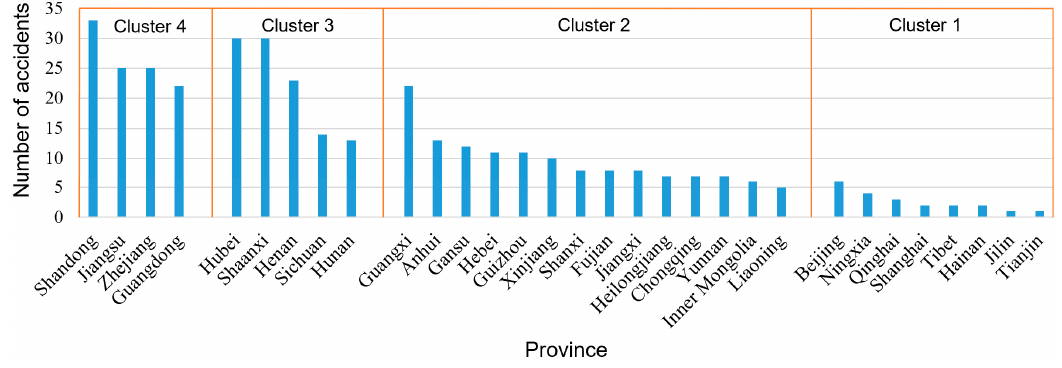
Figure 9. Clustering result dividing 31 provinces/cities into four groups.